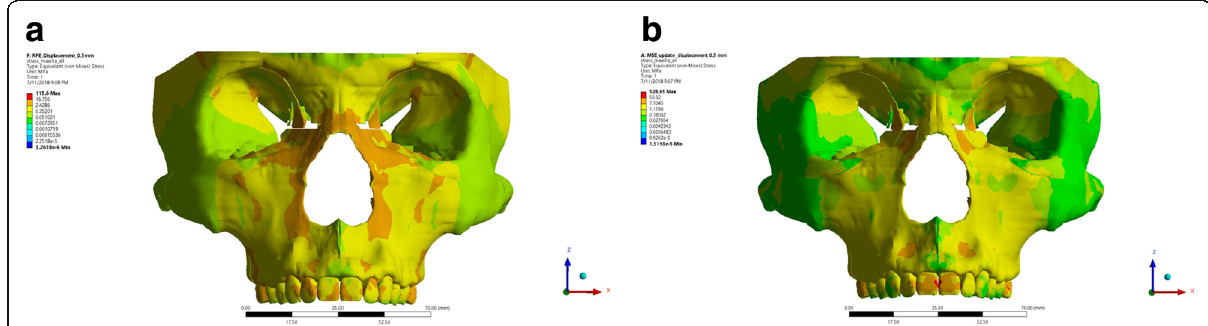
Fig. 7 Frontal aspect of stress distribution as the resut of expansion of RME ( a ) and MSE ( b